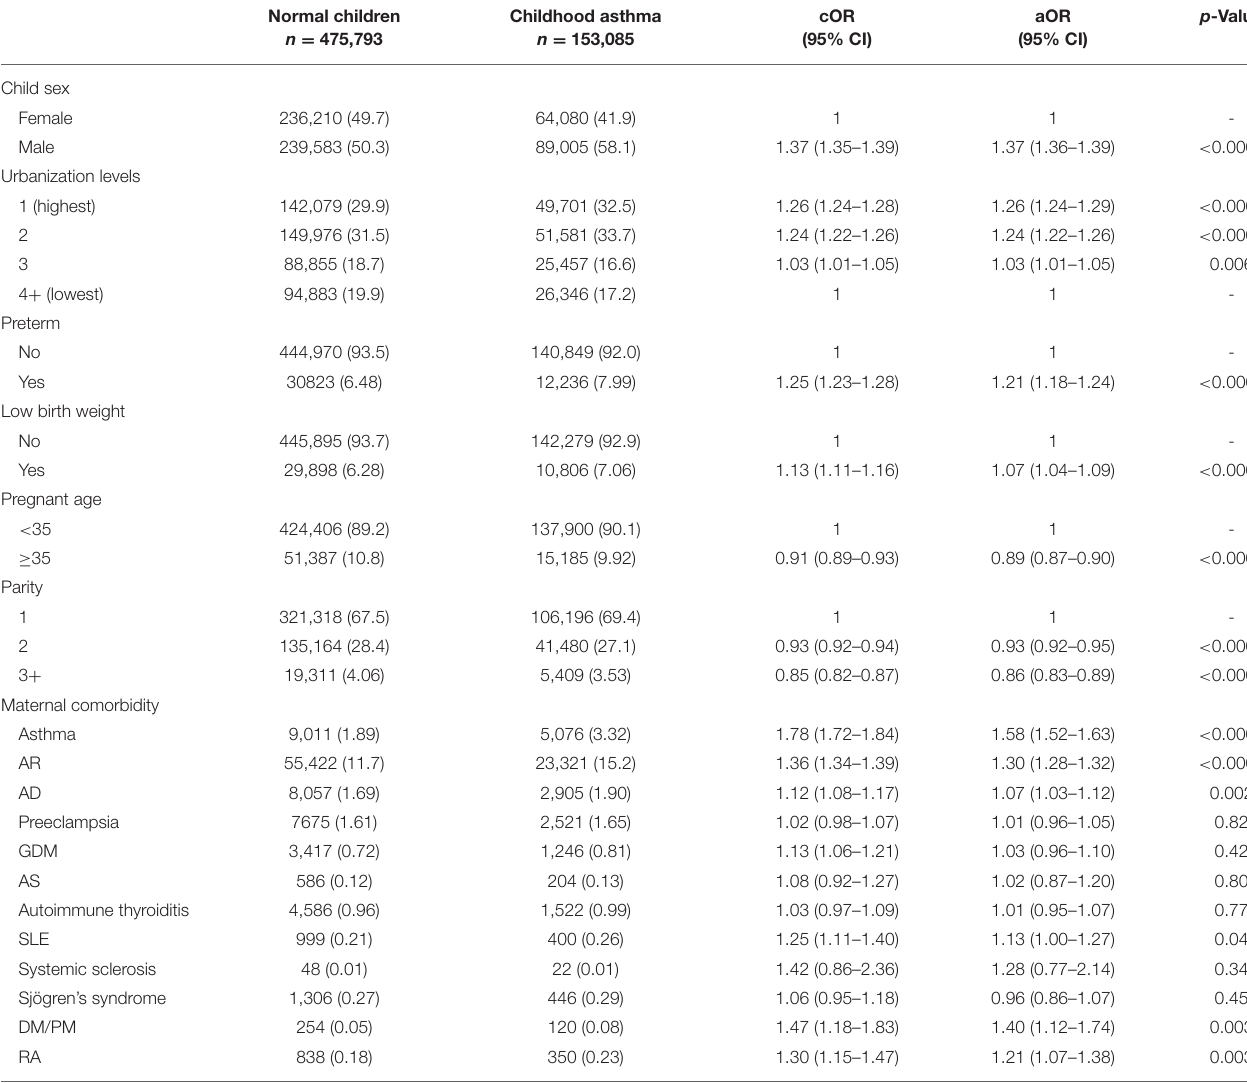
TABLE 2 | Risk of childhood asthma in different maternal pregnant conditions and